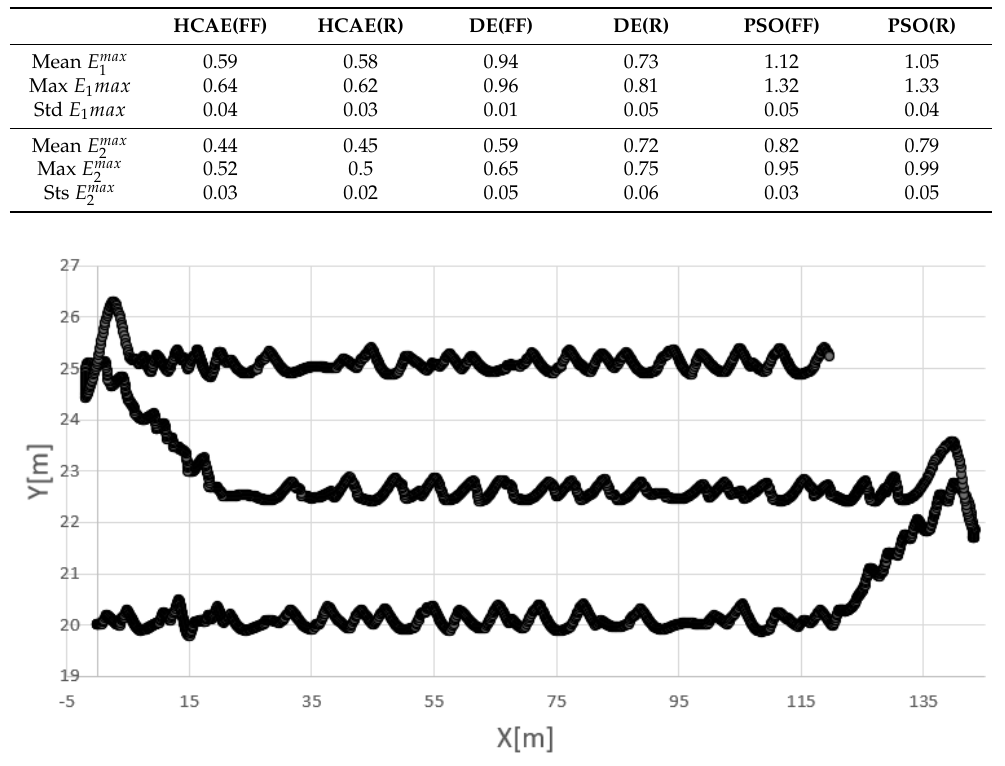
Figure 6. Example AUV